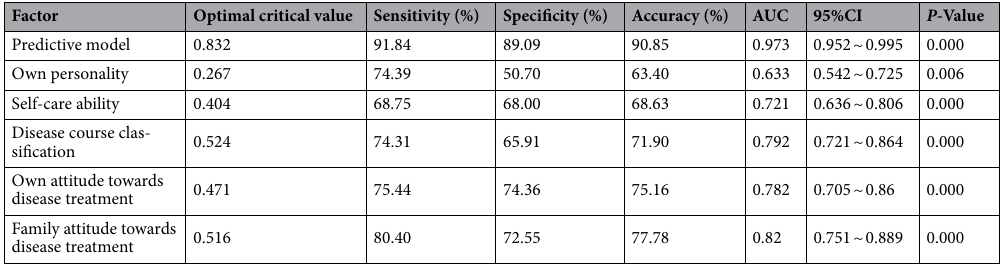
Table 4. Value of predictive model and various